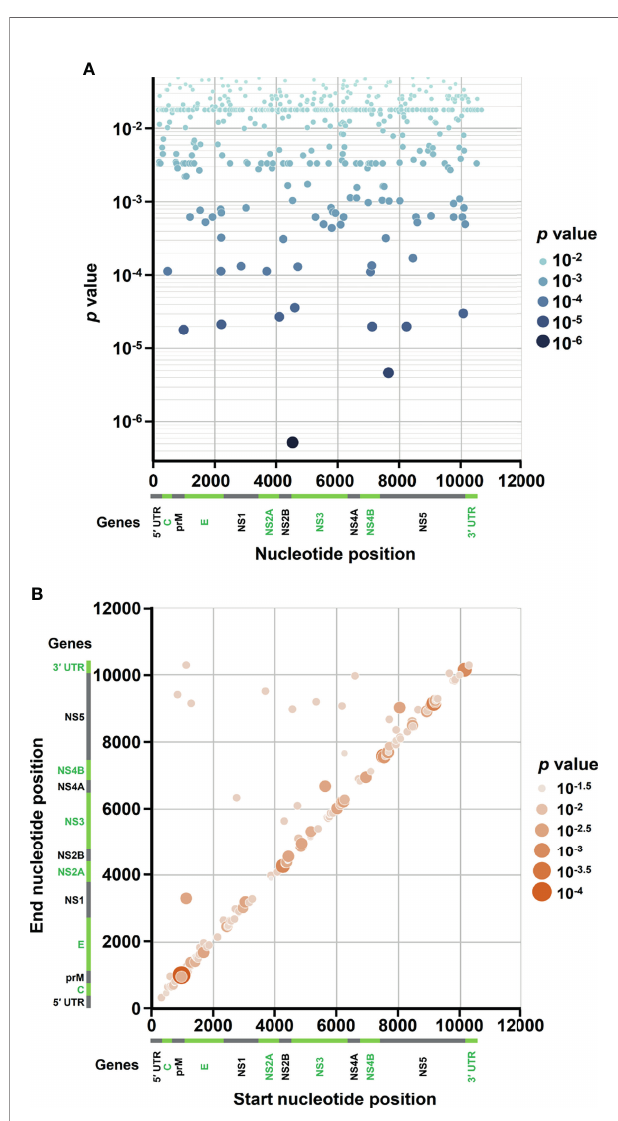
FIGURE 3 | Occurrence map of SNVs/DVGs associated with dengue disease outcomes in DENV-2 genome. Based on the nucleotide positions in DENV-2 genome, the occurrences of (A) 471 SNVs and (B) 160 DVGs in enrolled DENV-2-infected patients with p < 0.05 obtained using Mann – Whitney U test are shown. (A) SNVs dot plot mapping nucleotide positions (x-axis) and the p values of the association between each SNV and disease severity (y-axis), which assigns p values to continuous color and discrete size. (B) DVGs dot plot mapping the start and end positions of each junction region of the DVGs, which assigns p values of the association between each DVG and disease severity to continuous color and discrete